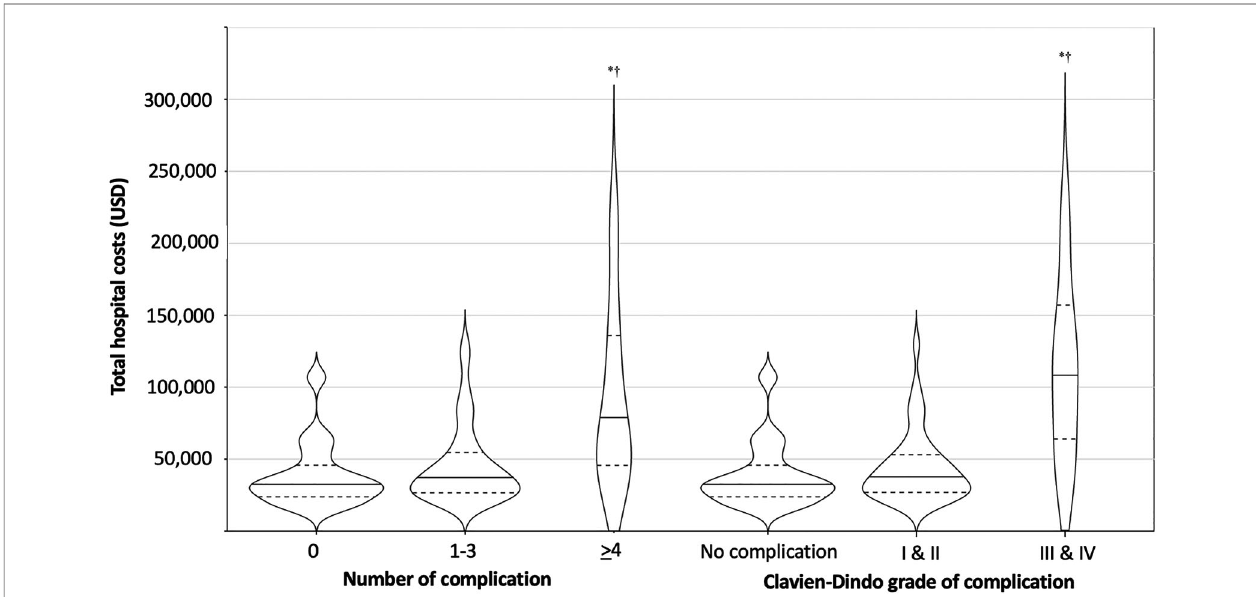
FIGURE 2 | Unadjusted hospital cost according to the number and severity of complications. Horizontal lines and dashes indicate the median and dashes represent the 25%, and 75% cost of corresponding number and severity of complications. The width of each violine plot response to the approximated frequency in each region. *: Bonferroni ’ s adjusted p <0.05 vs. no complications, † : Bonferroni ’ s adjusted p <0.05 vs. 1 – 3 complications or CVD I/II based on post-hoc Dunn ’ s test after the Kruskal – Wallis one-way analysis of variance on